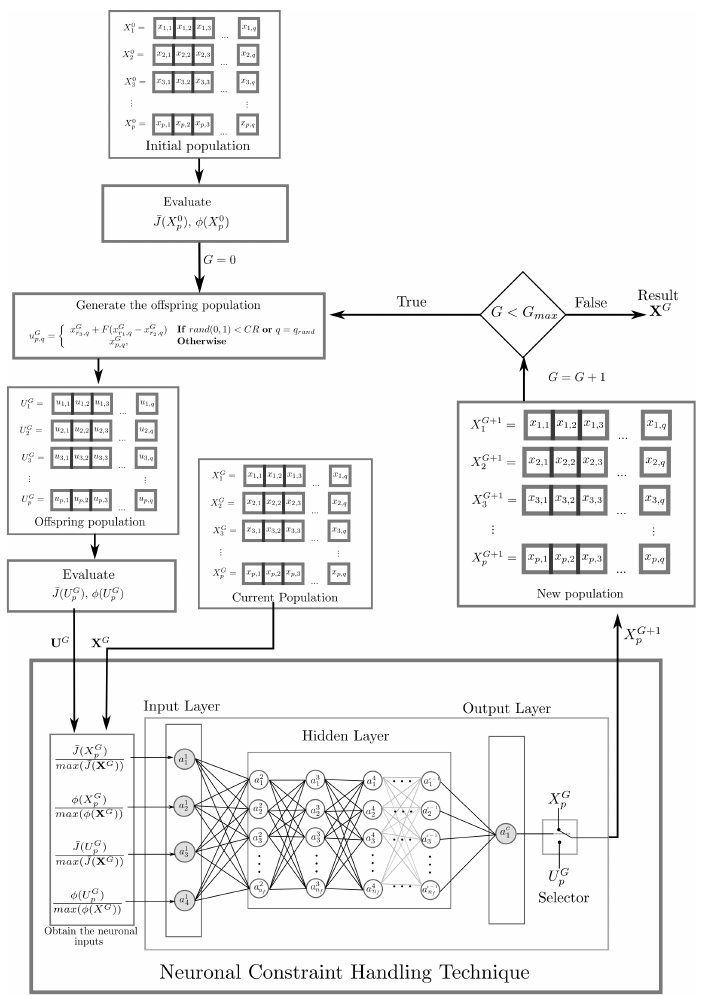
Figure 1. Neuronal constraint-handling technique.